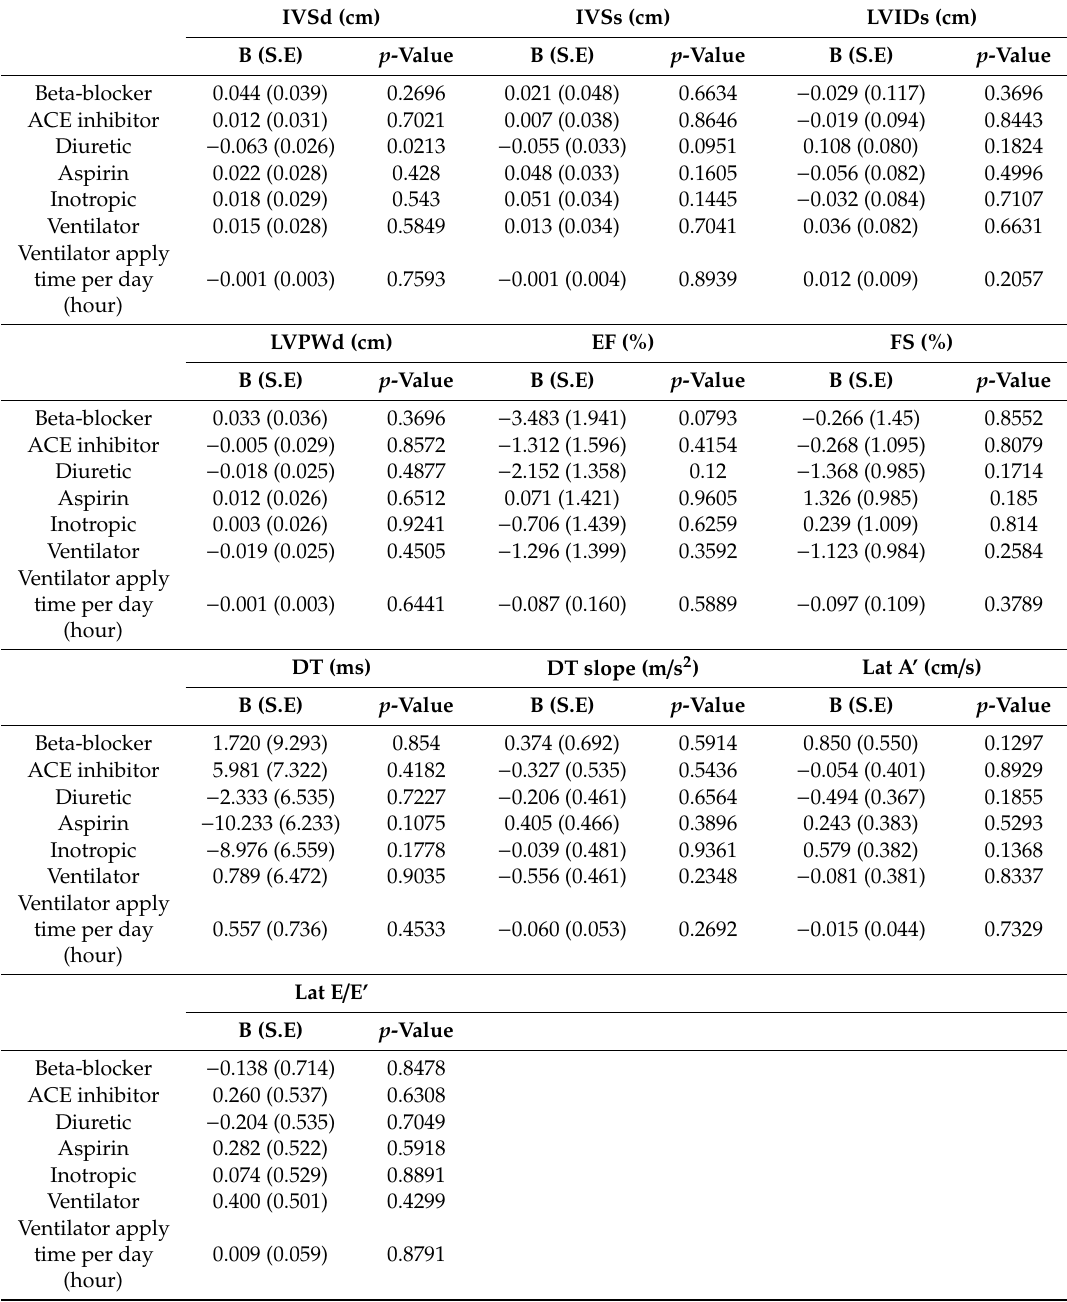
Table 3. Linear regression analysis of the e ff ect of cardiac medication and respiratory care on echocardiographic